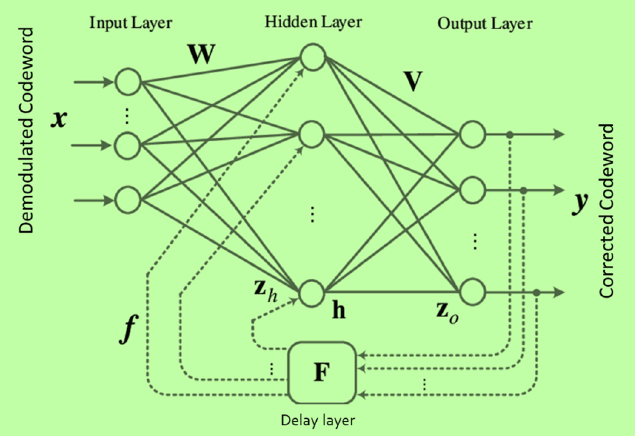
Figure 4. Recurrent neural network for forward error correction in regenerative